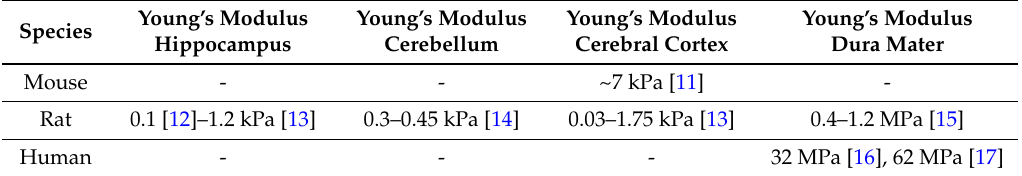
Table 1. Young’s modulus comparison between analogous brain structures in various